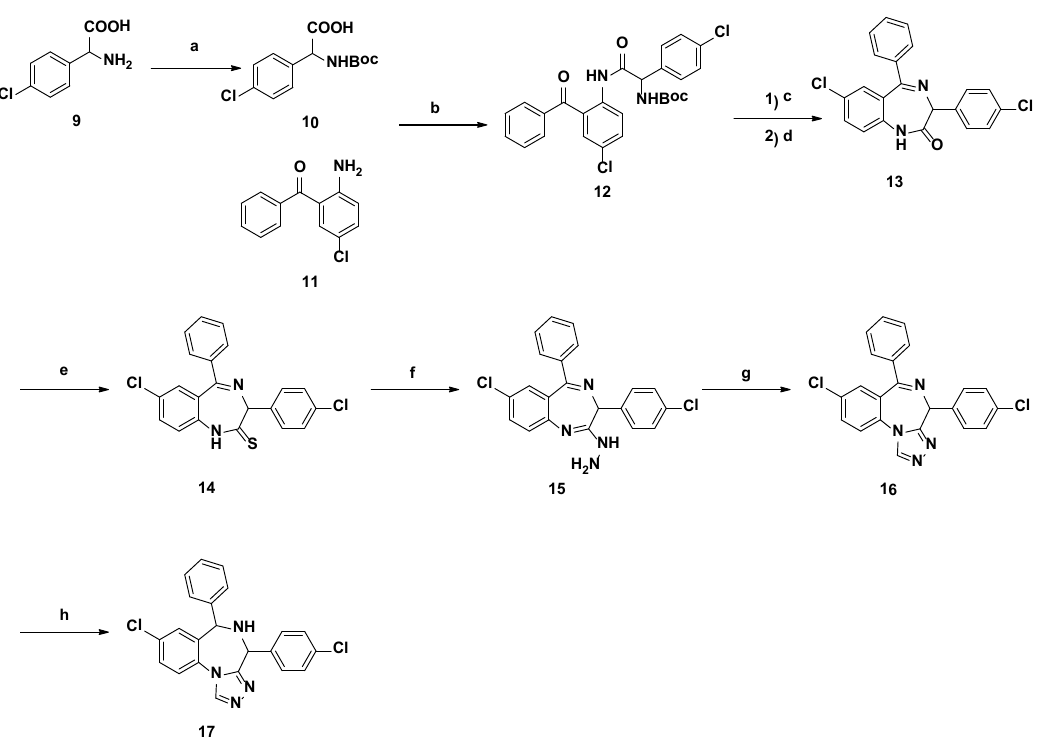
Scheme 2. Synthetic route of